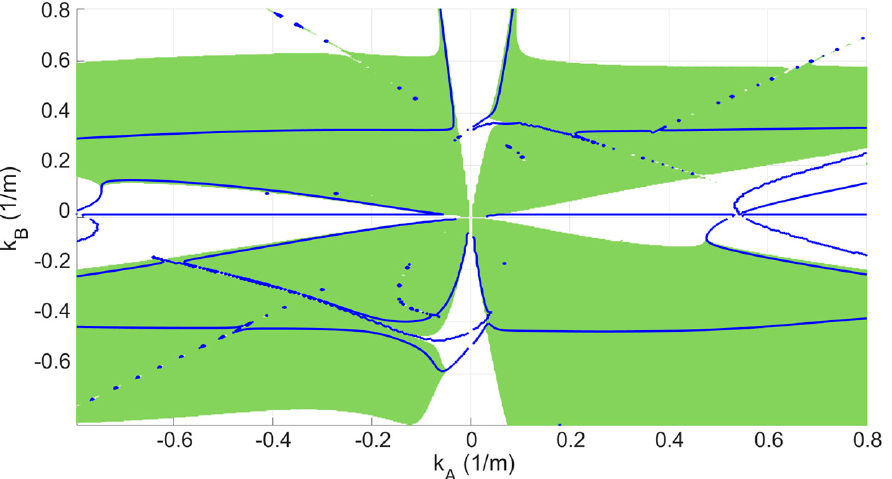
Figure 8. The region where − 2 ≤ F 2 ≤ 2 when U m = 0.5 m/s. The blue lines indicate where F 2 =